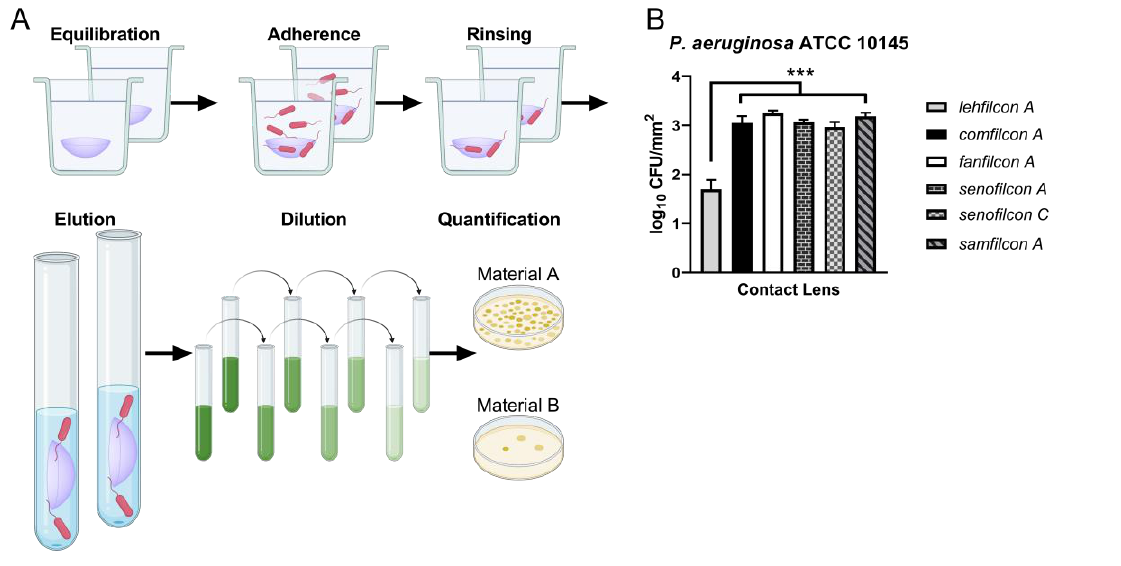
Figure 2. P. aeruginosa ATCC 10145 adheres poorly to lehfilcon A. ( A ) A depiction of the critical steps of the quantitative adhesion assay procedure used to compare contact lens materials. ( B ) Results of a quantitative adhesion assay of P. aeruginosa strain ATCC 10145 incubated with soft contact lenses (n = 6 individual contact lenses tested per material). The data are depicted as the average log density of colony forming units recovered from adhesion reactions (log10 CFU/mm 2 ) ± S.D. *** represents p < 0.0005 for comparison to lehfilcon A.